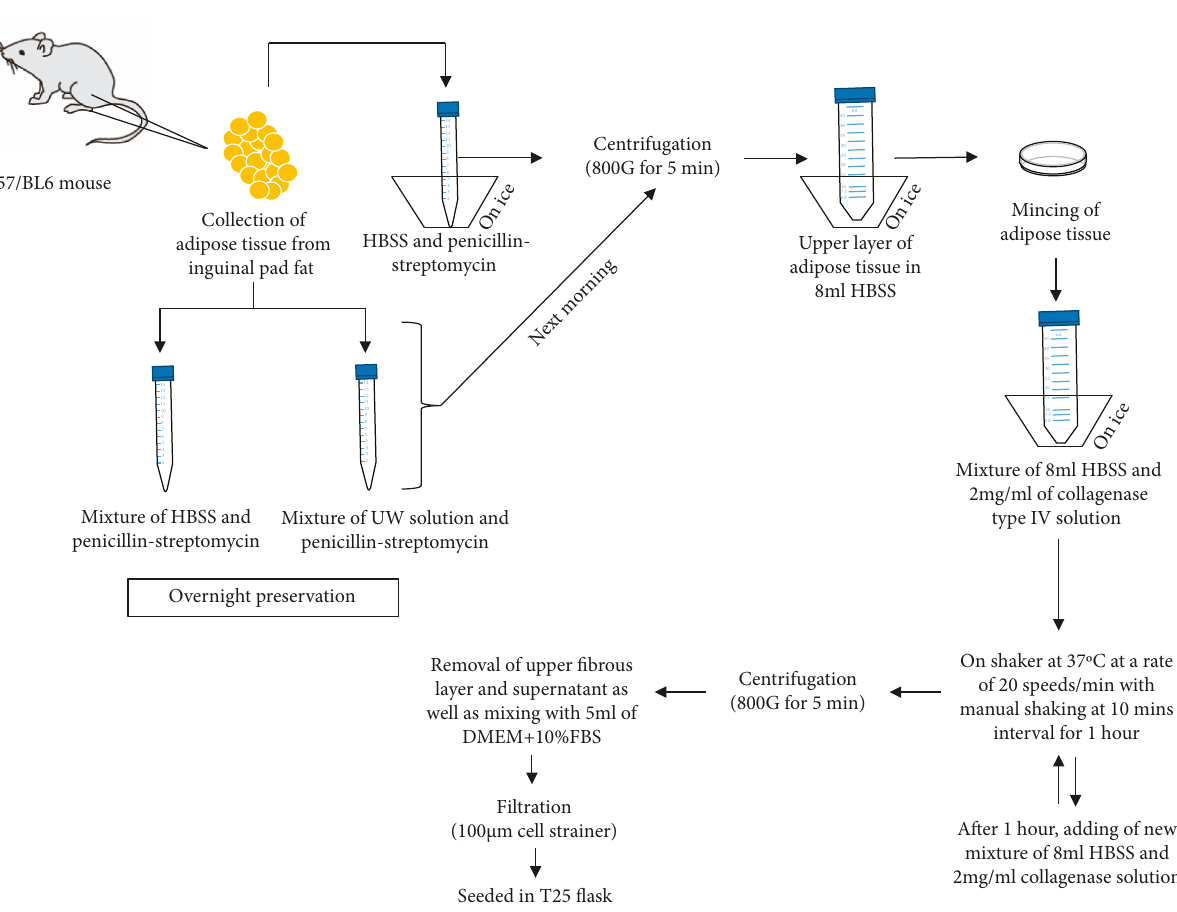
Figure 1: Illustration of the collection and preservation of adipose tissue-derived mesenchymal stem cells (ADSCs). ADSCs were isolated after storage of adipose tissue overnight in preservation solution (HBSS or UW solution). In the control group, ADSCs were isolated without preserving adipose tissue